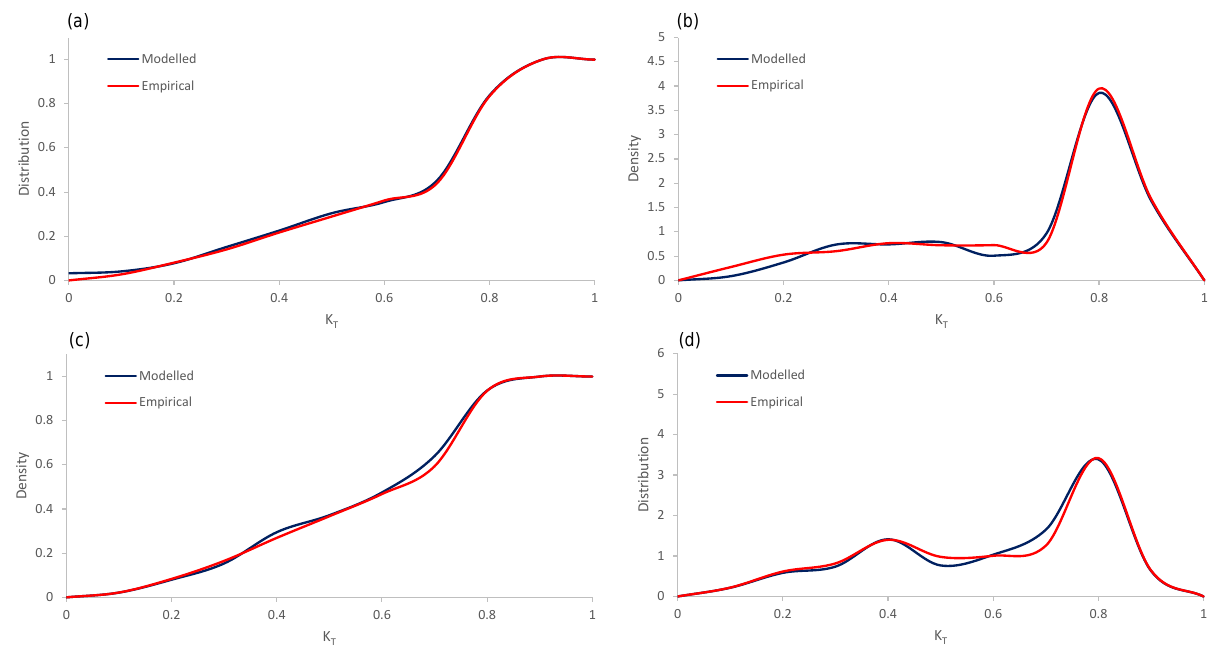
Figure 5. Comparison of distribution (a, c) and density (b, d) function of simulated and observed data, for hour 13:00: (a, b) May; (c, d)